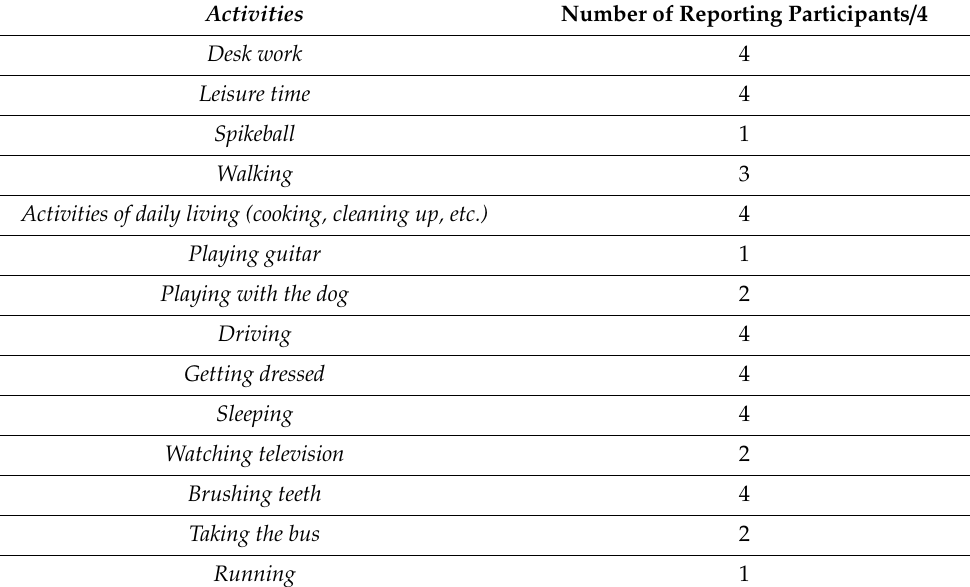
Table A1. A synthesis of the activities performed by subjects of the 24-h project (project